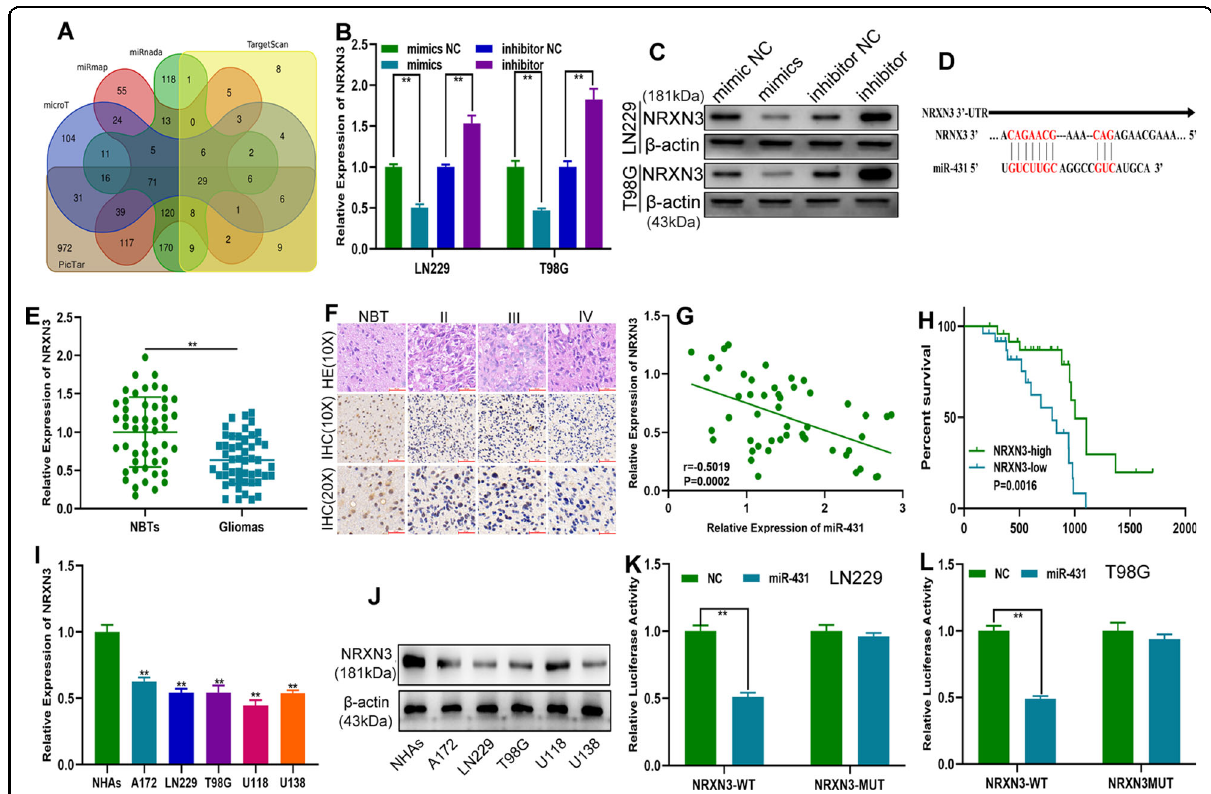
Fig. 5 MiR-431 directly binds NRXN3 to regulate the level of NRXN3. A A Venn diagram indicating that 29 mRNAs may be biological targets of miR-431. B , C qRT-PCR and western blot analysis showing NRXN3 expression in glioma cells transfected with miR-431 mimics, miR-431 inhibitor, and the corresponding negative control. D The putative binding sites of miR-431 on NRXN3. E The expression of NRXN3 in clinical glioma specimens and matching adjacent normal brain tissues (NBTs) was examined using qRT-PCR. F The expression level of NRXN3 in different malignancy grades of glioma detected using immunohistochemistry. G Pearson correlation analysis was performed to determine the relationship between NRXN3 and miR-431. H Kaplan – Meier survival analysis showed differences in the overall survival of glioma patients with high or low NRXN3 expression. I NRXN3 expression in glioma cells examined by qRT-PCR. J NRXN3 expression in glioma cell lines was examined using western blot analysis. K , L Dual- luciferase reporter assay to validate the association between NRXN3 and miR-431. Each experiment was performed in triplicate. Data are expressed as mean ± SD, ** P <